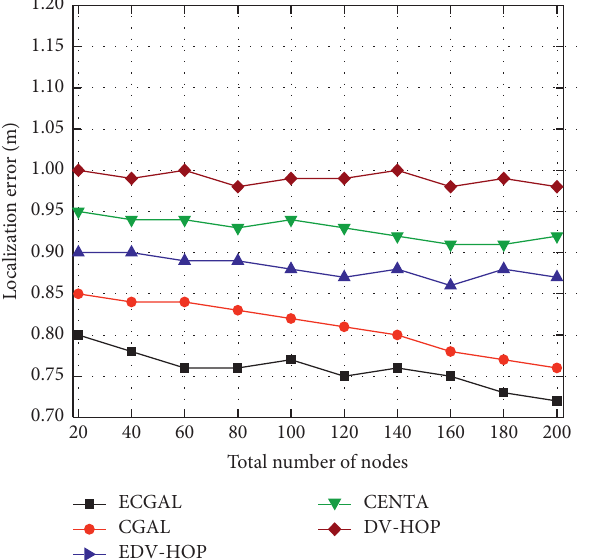
Figure 12: Localization error against the total number of nodes.